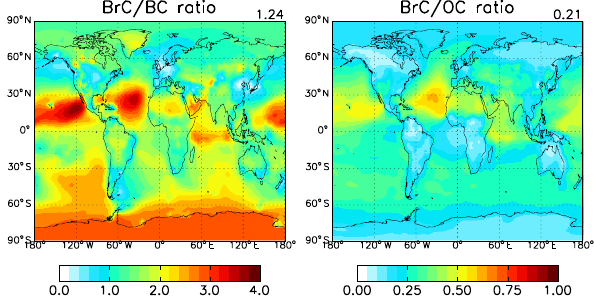
Figure 7. Annual mean ratios of BrC to BC (left) and OC (right) in surface air. Global mean values are presented in the upper right corner of each